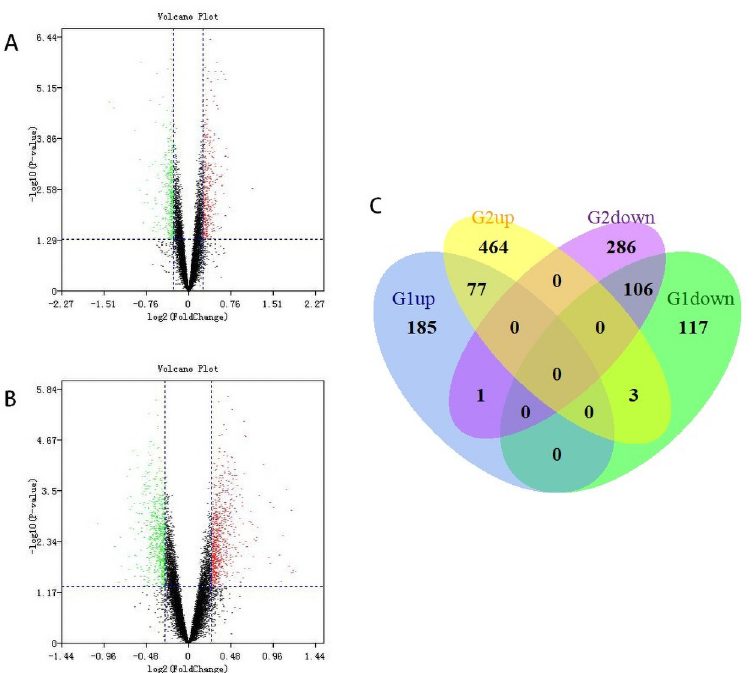
Fig 1. Identification of DEGs from GSE143272. (A) Volcano plot of DEGs in the male dataset. (B) Volcano plot of DEGs in the female dataset. Red, upregulation; green, downregulation. (C) Venn diagram of upregulated and downregulated DEGs based on the male (G1) and female (G2) datasets.